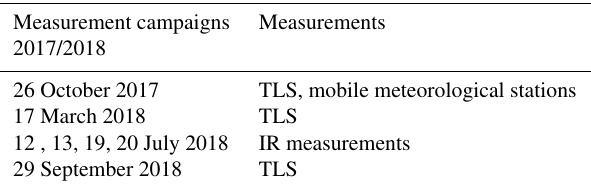
Table 2. Measurement campaigns conducted in 2017 and 2018. Measurement